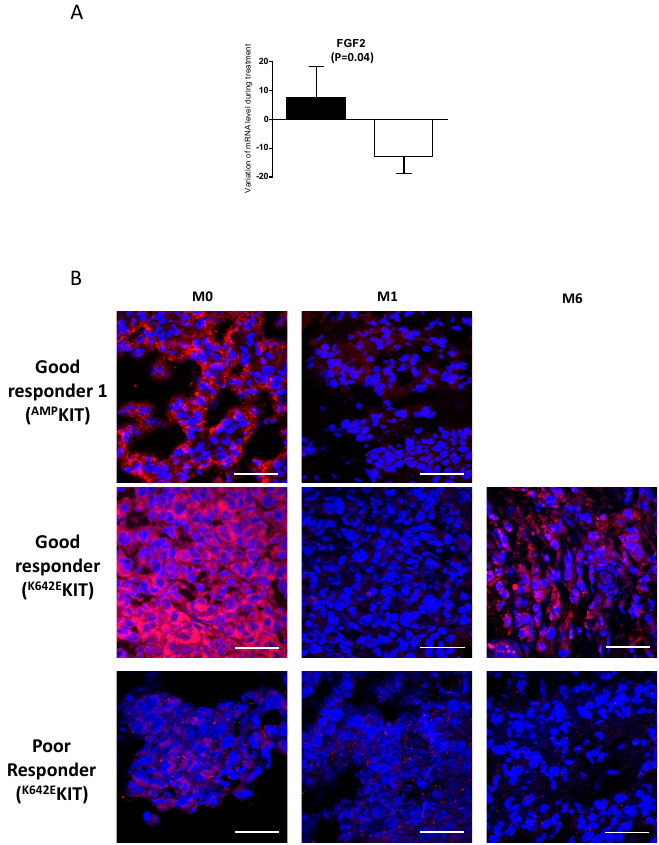
Figure 2. Variation of FGF2 expression during treatment. ( A ) Variation in expression between baseline and after 1 month of treatment with nilotinib of FGF2 mRNA expression, in patients treated with nilotinib with poor (black bar) or good (white bar) response following RECIST (respectively, n = 8 and n = 5). Box plot: middle bar, median; lower and upper box limits, 25th and 75th percentiles, respectively; whiskers, min and max values. Variables were compared with the Mann–Whitney test one tailed. ( B ) FGF2 expression in tumors assessed by immunofluorescence. Representative photographs of FGF2 stained in red in two good responders and a poor responder at baseline, and after 1 (M1) and 6 months (M6) of treatment. KIT alterations are indicated for each patient ( AMP KIT = amplification of the KIT locus). DAPI stained cell nuclei (blue). Scale bar, 50 µm.